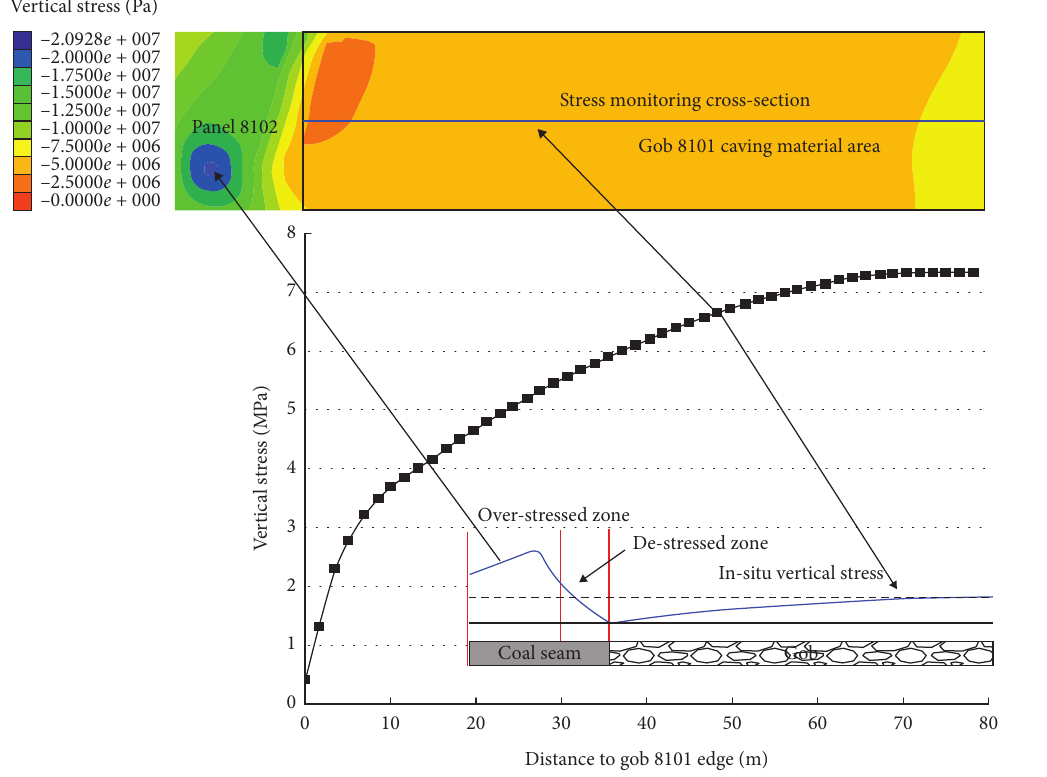
Figure 16: The vertical stress distribution in gob 8101.